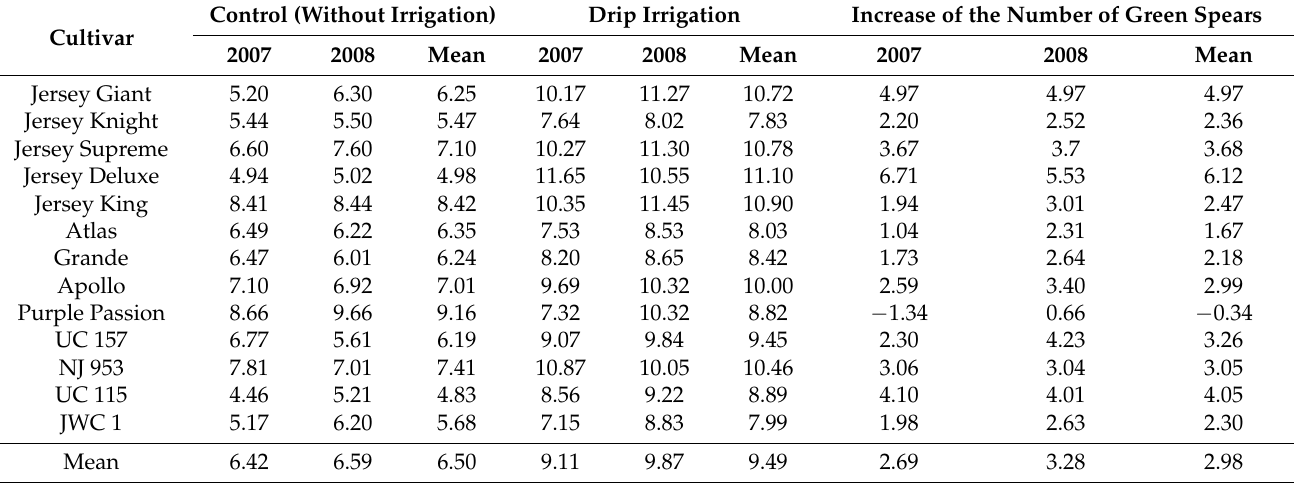
to 9.49 (Table 12). Green spears number per plant increased due to drip irrigation for the studied cultivars and 2 years of research, on average, by 2.98 pcs (46%). The highest increase in green spears number per plant (10 or more) under drip irrigation conditions, on average, for 2 years of research, was observed for the cultivars Jersey Deluxe (11.10), (10.00). The best response to drip irrigation, with reference to this characteristic, was noted in Jersey Deluxe cultivar. Drip irrigation increased the number of green spears per plant in this cultivar by more than six spears (i.e., by 123%). Hartmann [9], Paschold et al. [11], Rolbiecki and Rolbiecki [2], and Rolbiecki [14] also obtained an increase in the number of asparagus spears due to drip irrigation. Table 12. Number of the asparagus green spears (pcs) as dependent on cultivar and irrigation.